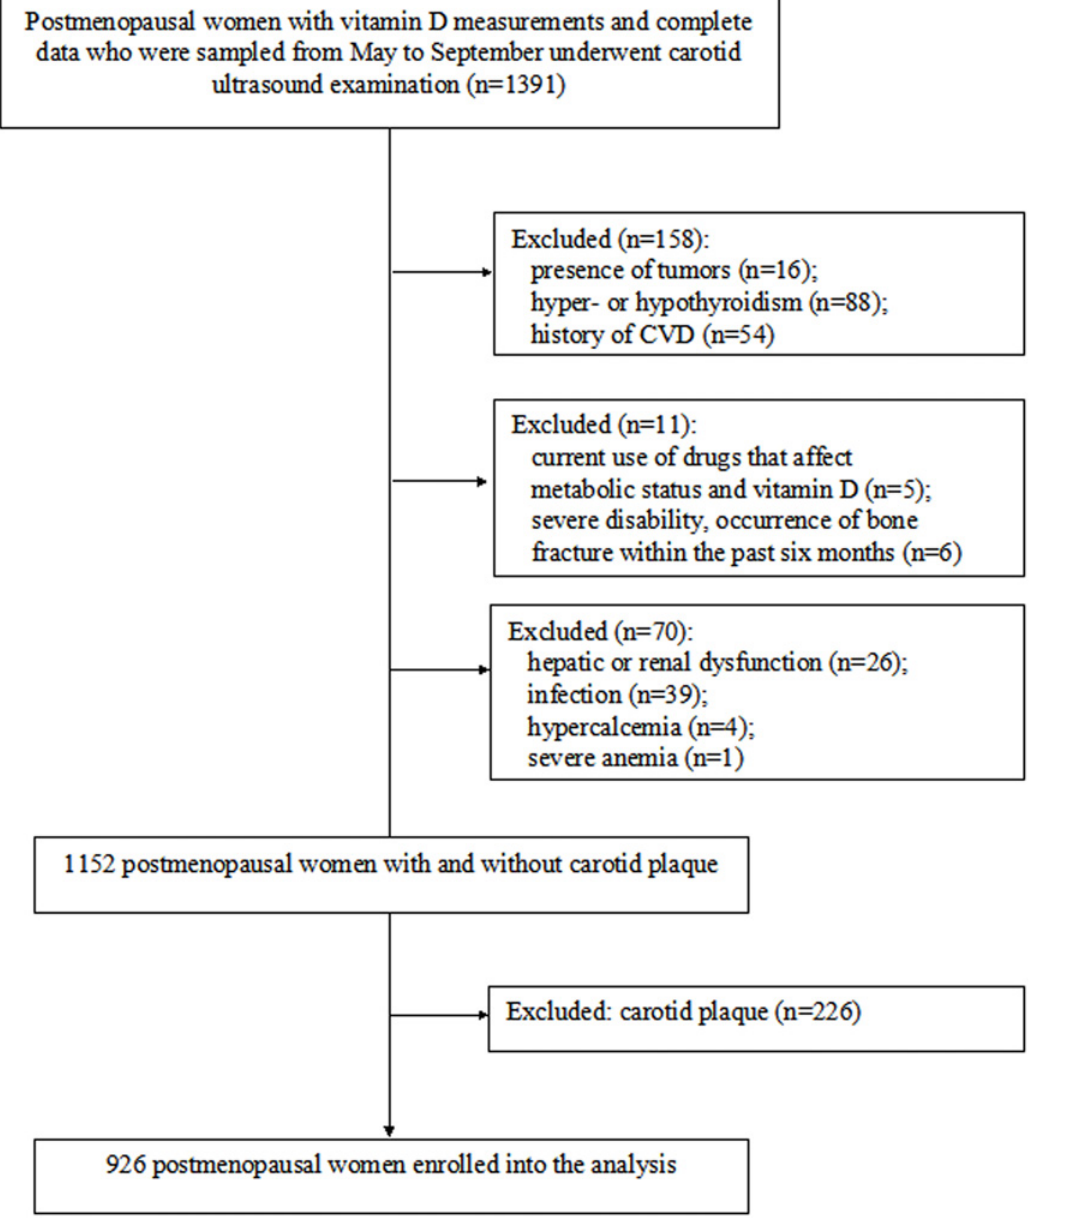
Fig 1. Flow chart for the selection of the study